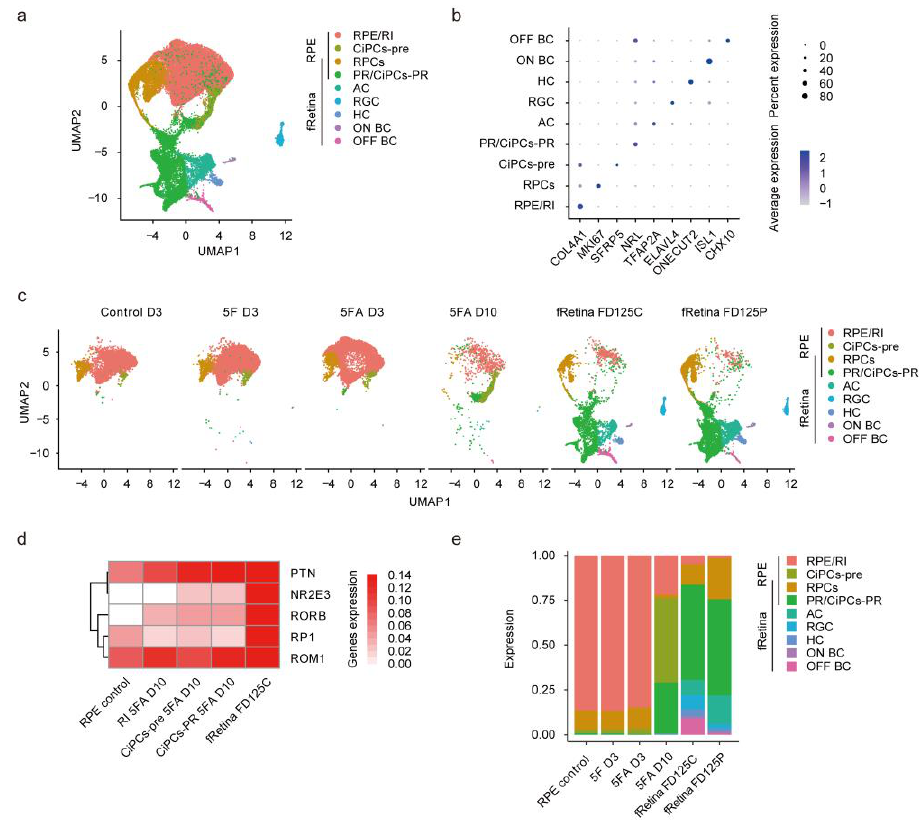
Figure 7. RPE-derived CiPCs resemble fetal retinal neurons. ( a ) UMAP analysis demonstrating clusters obtained by integrating analysis between single-cell RPE datasets and fRetina datasets. FD, fetal day. Cluster annotations: RI, RPE reprogramming intermediates; RPCs, retinal progenitor cells; CiPCs-pre, CiPCs-precursor, separate from fRetina; CiPCs-PR, CiPCs-photoreceptors, overlapping cells of CiPCs and fetal photoreceptors; PR, photoreceptors; AC, amacrine cells; RGC, retinal ganglion cells; HC, horizontal cells; ON BC, ON bipolar cells; OFF BC, OFF bipolar cells. ( b ) Dot plot showing the identified markers for each cell subtype. ( c ) UMAP analysis demonstrates the identified cell subtypes in different samples. fRetina D125C, human fetal retina at fetal day 125, central area. fRetina D125P, human fetal retina at fetal day 125, peripheral area. Integrating the scRNA-seq datasets of human fetal retina helped to define subgroups of CiPCs-pre and CiPCs-PR, thus the shape of the CiPCs cluster was different from that in Figure 5b (without fetal retina). ( d ) Heatmap showing the expression of photoreceptor marker genes in different samples. ( e ) Bar plot showing the proportion of each cell subtype identified in different samples.